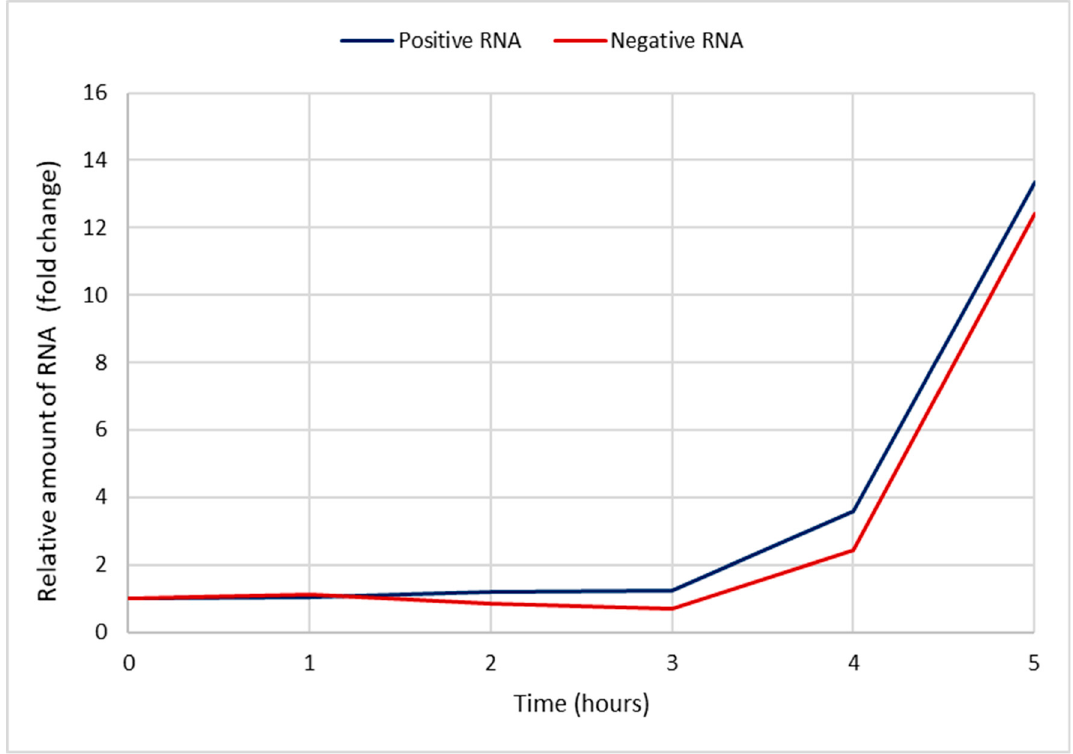
Figure 9. The increase in the relative amounts of viral +RNA and − RNA during a CVA9 infection compared to timepoint 0 h p.i. The data were plotted from the RT-qPCR results presented in Figure 4 by calculating the fold change with Equation (3). The x -axis shows the time post-infection, and the y -axis shows fold change (how many times higher the amount of RNA is compared to 0 h p.i.). The +RNA is shown in blue, and − RNA is shown in red. The pace at which the amounts of RNAs increased was almost identical.